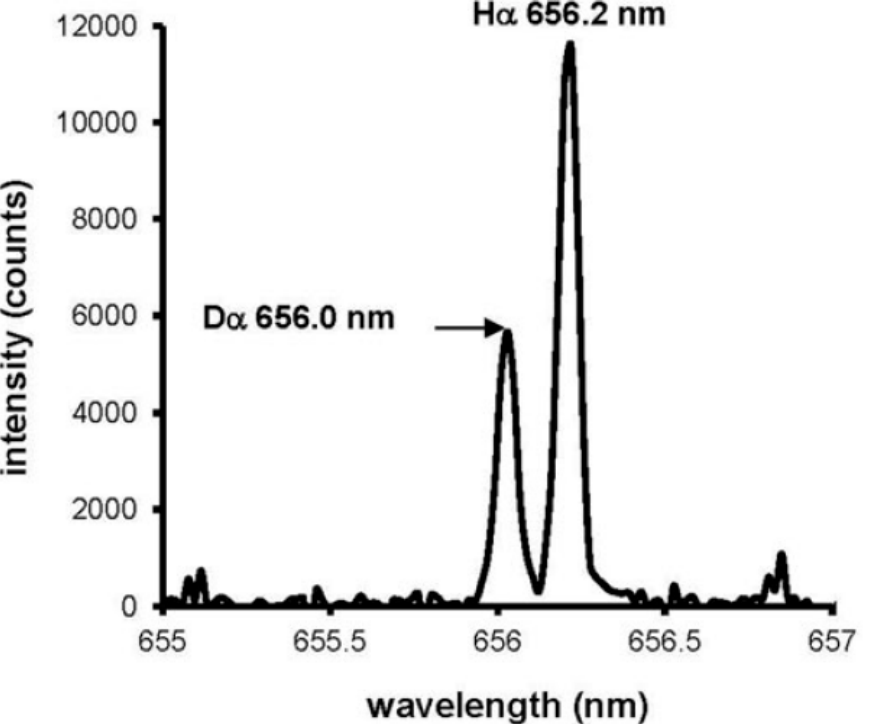
Figure 7. Fully resolved LIBS spectrum of H α and D α lines, from a fossil sample painted on the surface with heavy water. The spectrum was measured under helium gas at 5 torr. Reprinted with permission from [72]. Copyright 2006 American Chemical Society.